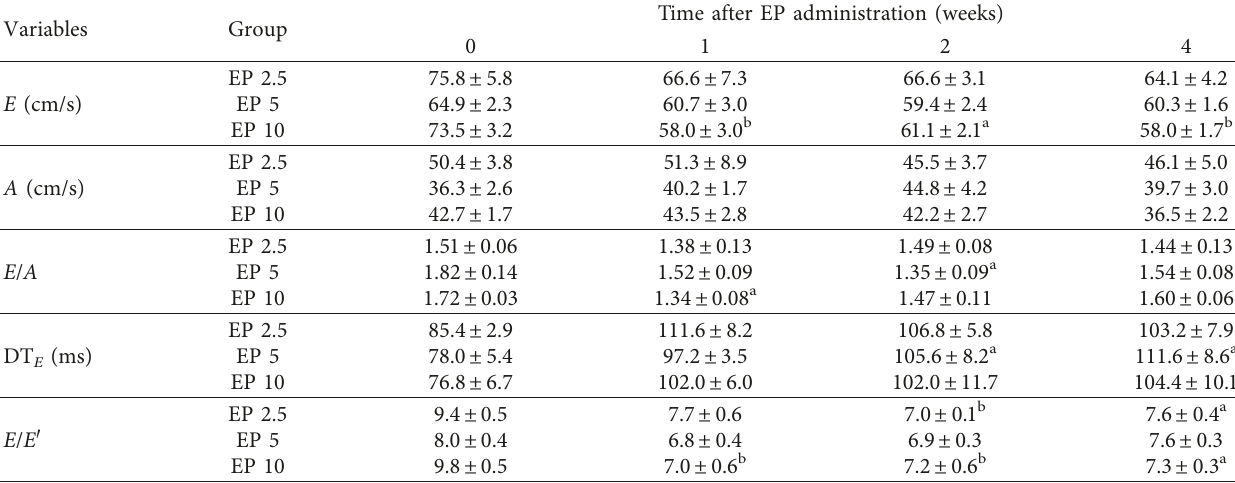
Table 1: Peak velocity of early diastolic transmitral flow ( E ), peak velocity of late transmitral flow ( A ), ratio of the peak velocity of early diastolic transmitral flow to the peak velocity of late transmitral flow ( E / A ), deceleration time of early diastolic transmitral flow (DT E ), and ratio of the peak velocity of early diastolic transmitral flow to peak the velocity of early diastolic septal mitral annular motion ( E / E ′ ) values after eplerenone (EP) administration in dogs.